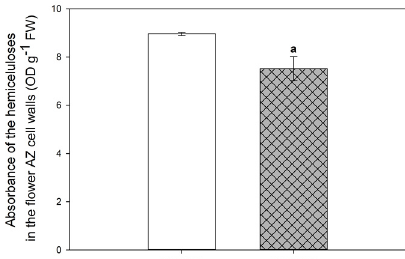
Figure 6. Hemicellulose content is negatively regulated by soil water deficit. The e ff ect of drought stress (25% WHC, water deficit conditions) on the absorbance of hemicelluloses in the flower abscission zone (AZ) of yellow lupine was analyzed. Control AZ fragments were collected from plants growing in the soil of optimal conditions (70% WHC). For analysis, sections of AZs were harvested on the 48th day of cultivation. Data are presented as averages ± SE ( n = 3). Significant di ff erences in the stressed plants in comparison to control plants are a p < 0.05 (Student’s t